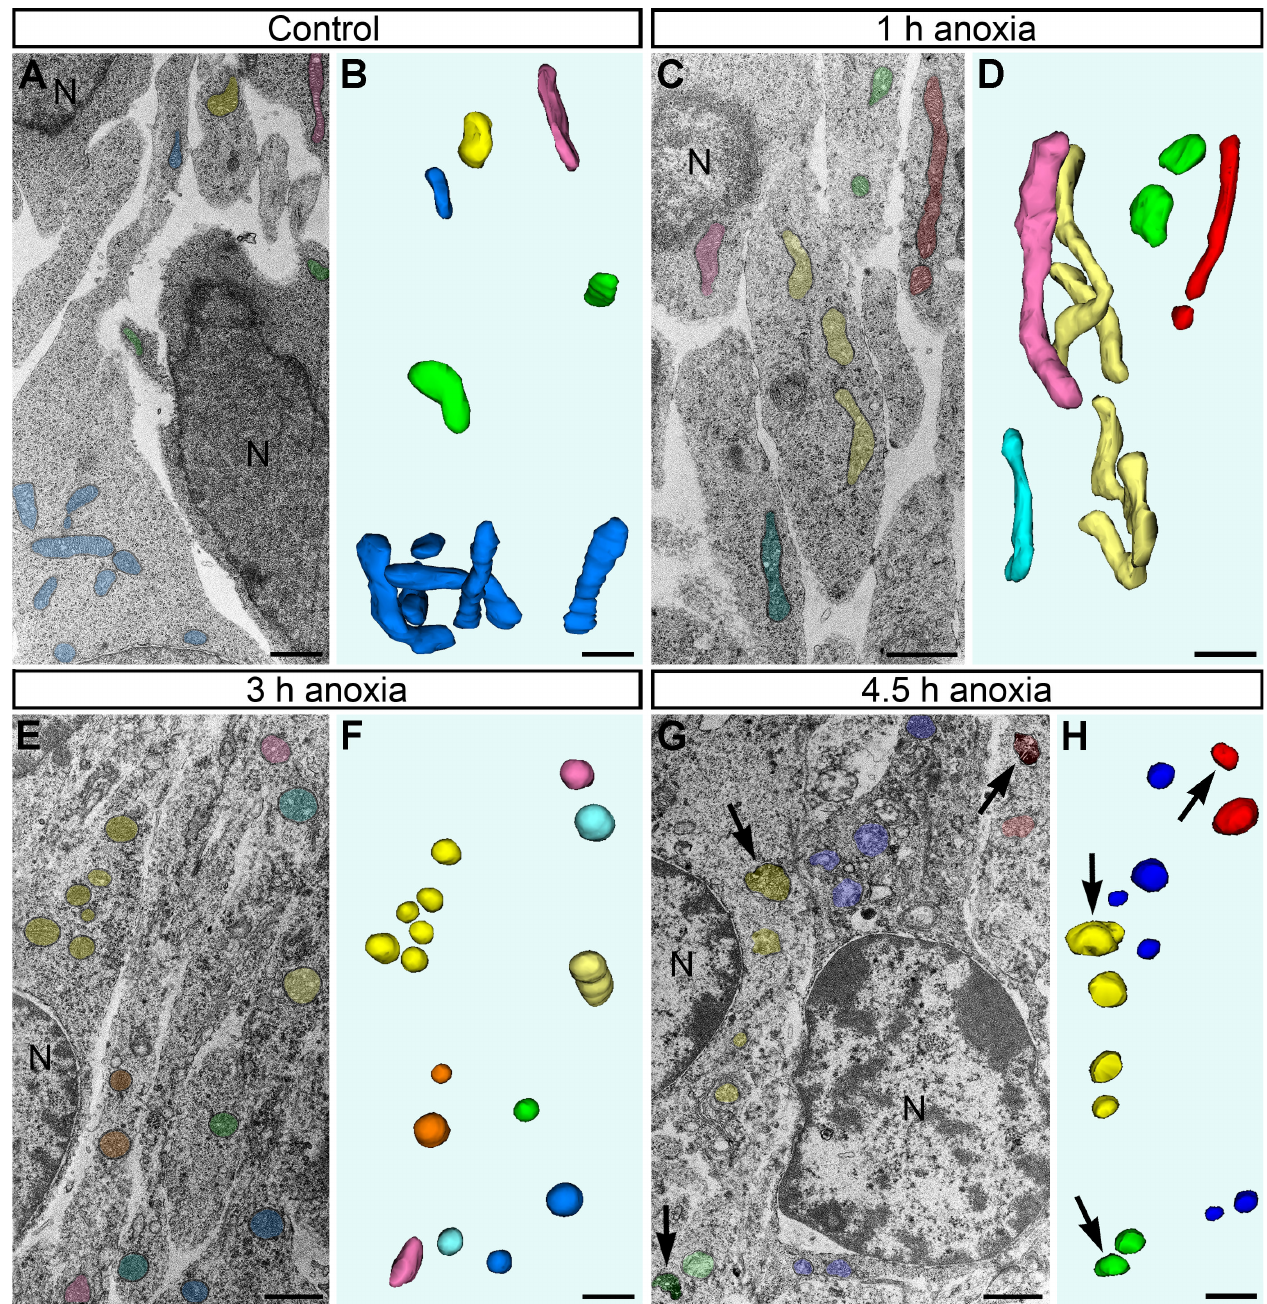
reconstruction ( G ) demonstrate spherical onion-like shape of GA after 1 h anoxia. Abbreviation: N, cell nucleus. Scale bars, 500 nm.